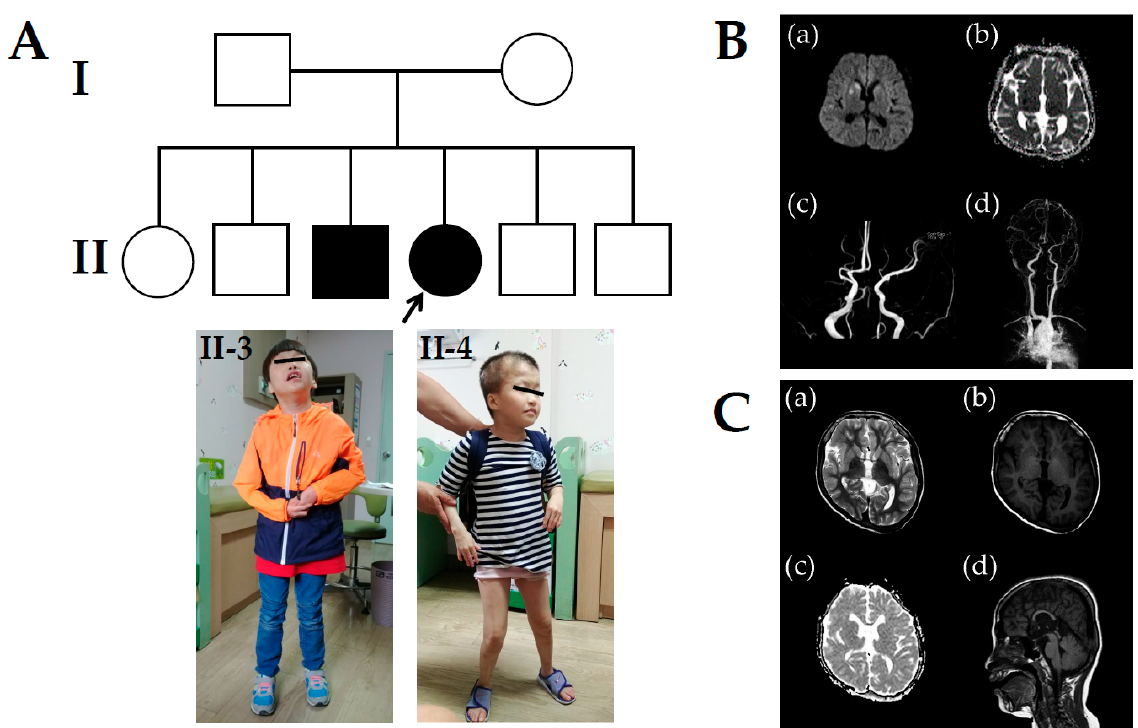
Figure 1. Pedigree analysis, clinical imaging, and brain magnetic resonance imaging (MRI) and angiography (MRA) in the proband (II ‐ 4) and her elder brother (II ‐ 3). ( A ) Pedigree analysis and clinical photography. (Upper panel) Family pedigree shows a recurrent and dominant de novo duplication of 14q32.11 ‐ q32.33 in Korean siblings associated with intellectual disability, growth retardation, facial dysmorphism, and cerebral infarction. (Lower panel) A dysmorphic face characterized by frontal bossing, widely spaced teeth, broad upper alveolar ridges, broad mouth, downturned corners of the mouth, broad nasal root, and deep nasal bridge. ( B ) The proband showed acute infarction in the right striatocapsular region and cortical area of the right temporal lobe ( a and b ). The proximal M1 segment of right MCA was occluded, and the distal MCA was retrograde filled by leptomeningeal collaterals ( c and d ). ( C ) Her elder brother showed abnormal development of the right hemisphere combined with cortical dysplasia ( a and b ) and dysgenesis of the corpus callosum ( c and d ).